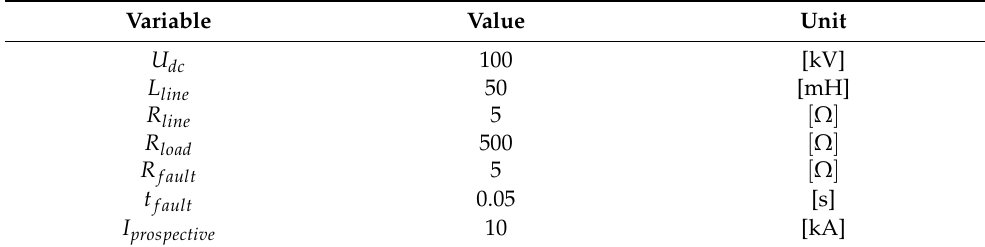
Table 1. Test grid parameters.